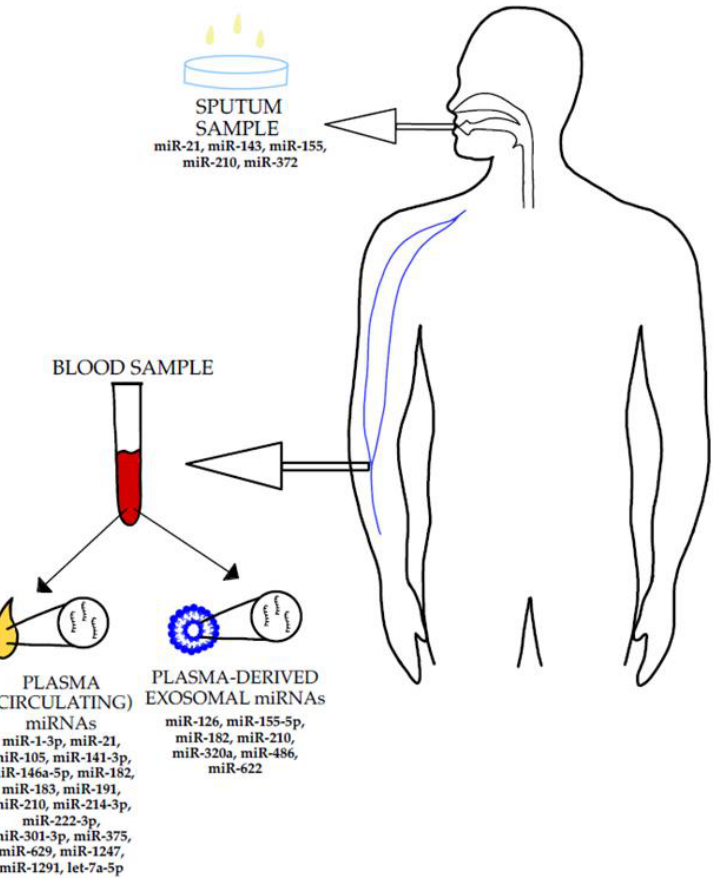
Figure 2. The figure illustrates the sample types that could be utilis ed to examine the miRNAs’ ex- pression levels in a non-invasive manner